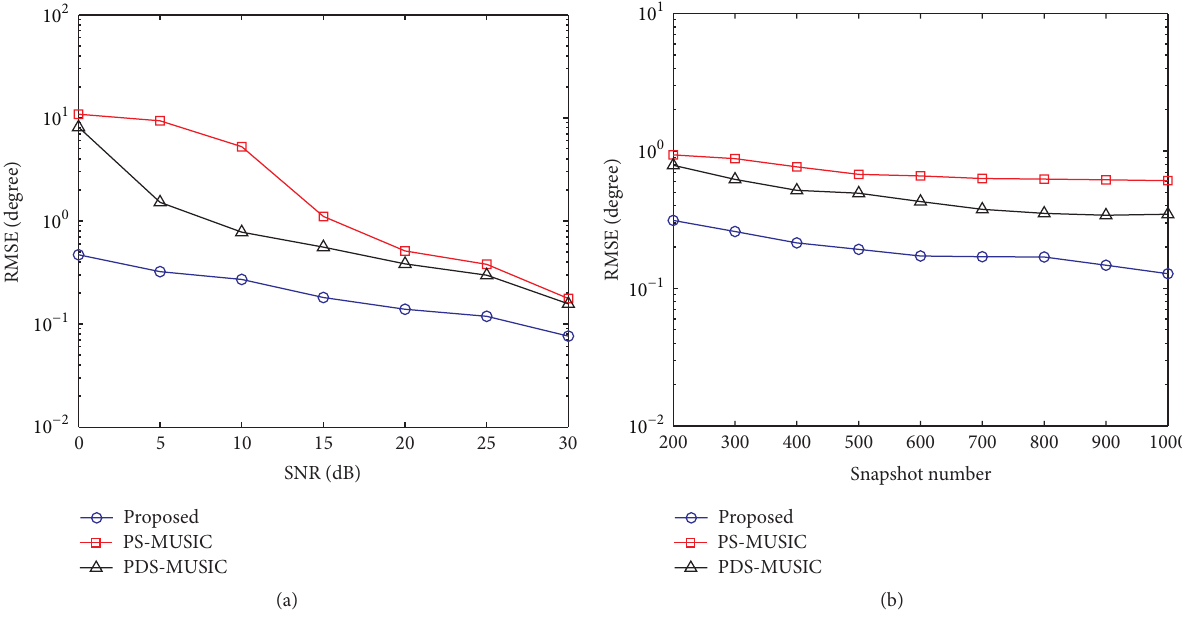
Figure 7: Comparison of RMSE of angle estimation of the proposed, PS-MUSIC, and PDS-MUSIC methods versus SNR and snapshot number: (a) RMSE versus SNR with the fixed snapshot number 500; (b) RMSE versus snapshot number with the fixed SNR 20